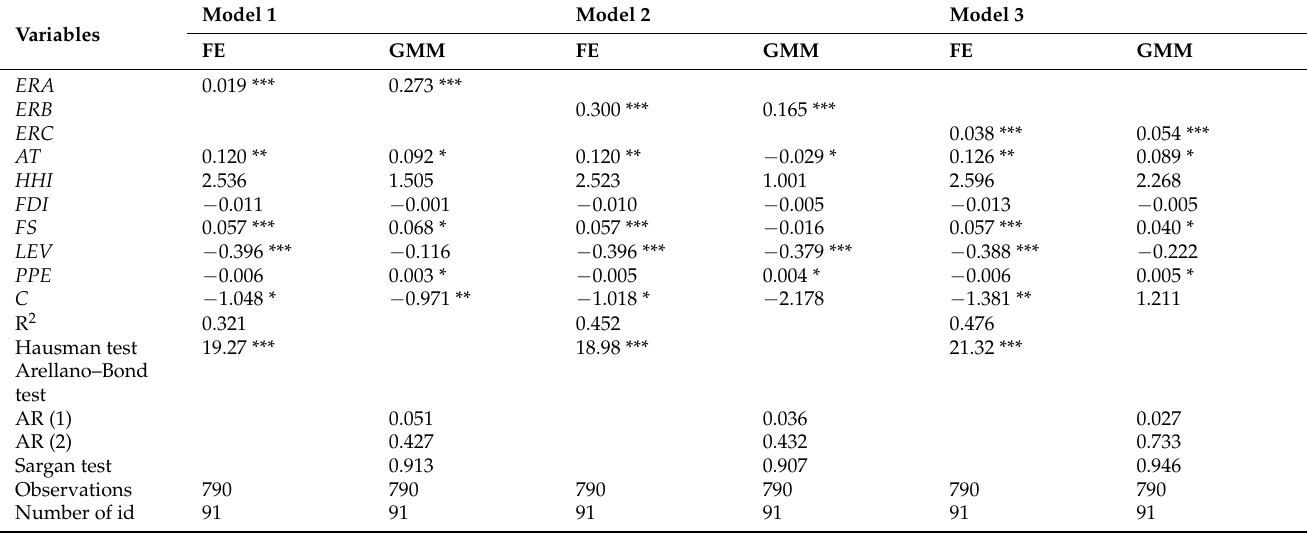
Table 4. Measurement results of the relationship between ER and SG .